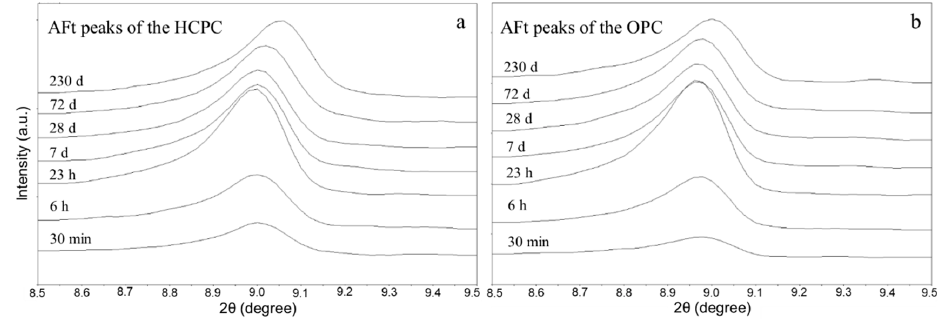
Figure 2. Stepping scan patterns of the AFt’s characteristic peak of the HCPC ( a ) and the OPC ( b ) at different hydration ages.